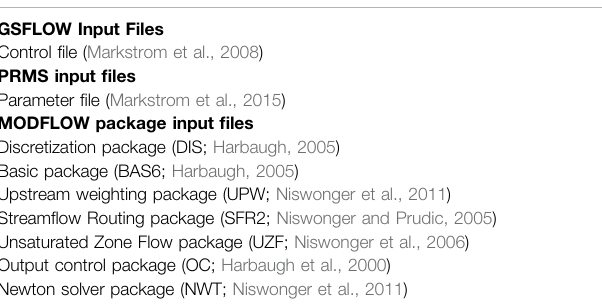
automaticallypopulatedwithdefaultvaluesandinsteadtheusermustspecifytheir climate